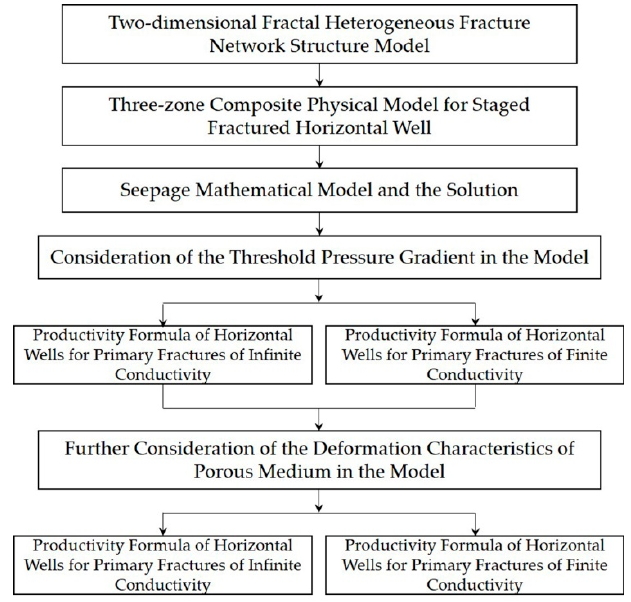
Figure 7. Flow chart of established productivity model.